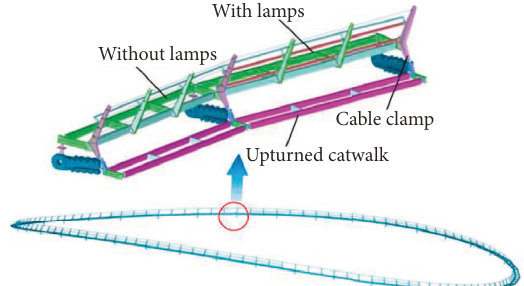
Figure 14: 3D diagram of the circular catwalk.